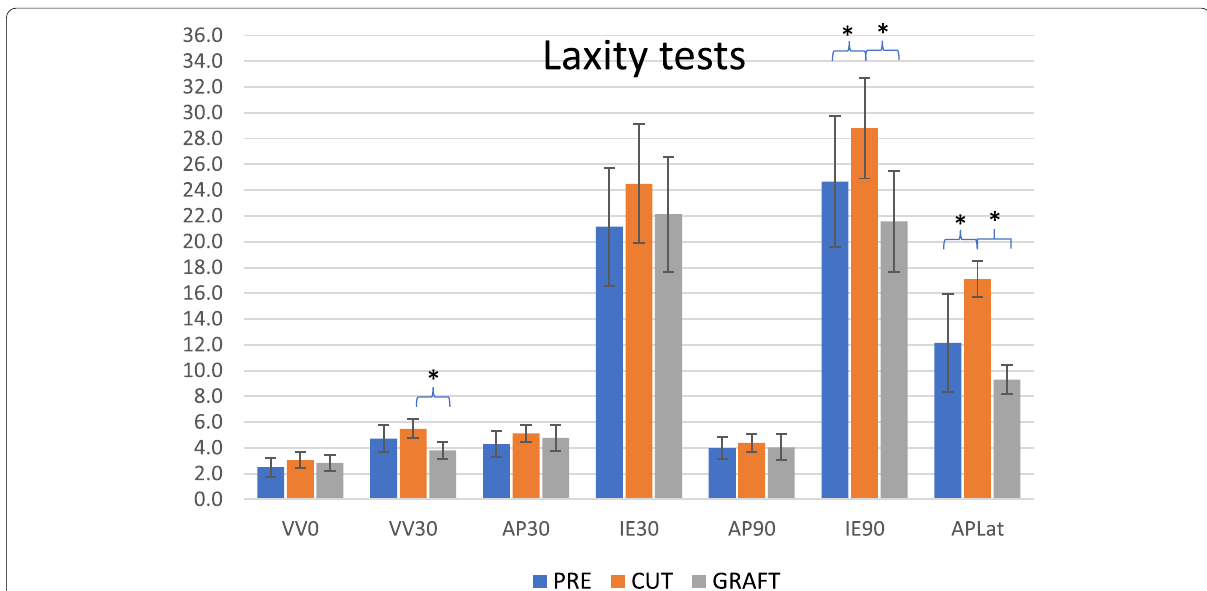
Fig. 4 Histogram representing the mean values of laxity measured during test sessions. ALL resection significantly increased laxity in IE90 and APlat (* p < .05). Nevertheless, ALL reconstruction significantly reduced laxity in IE90 and APlat (* =